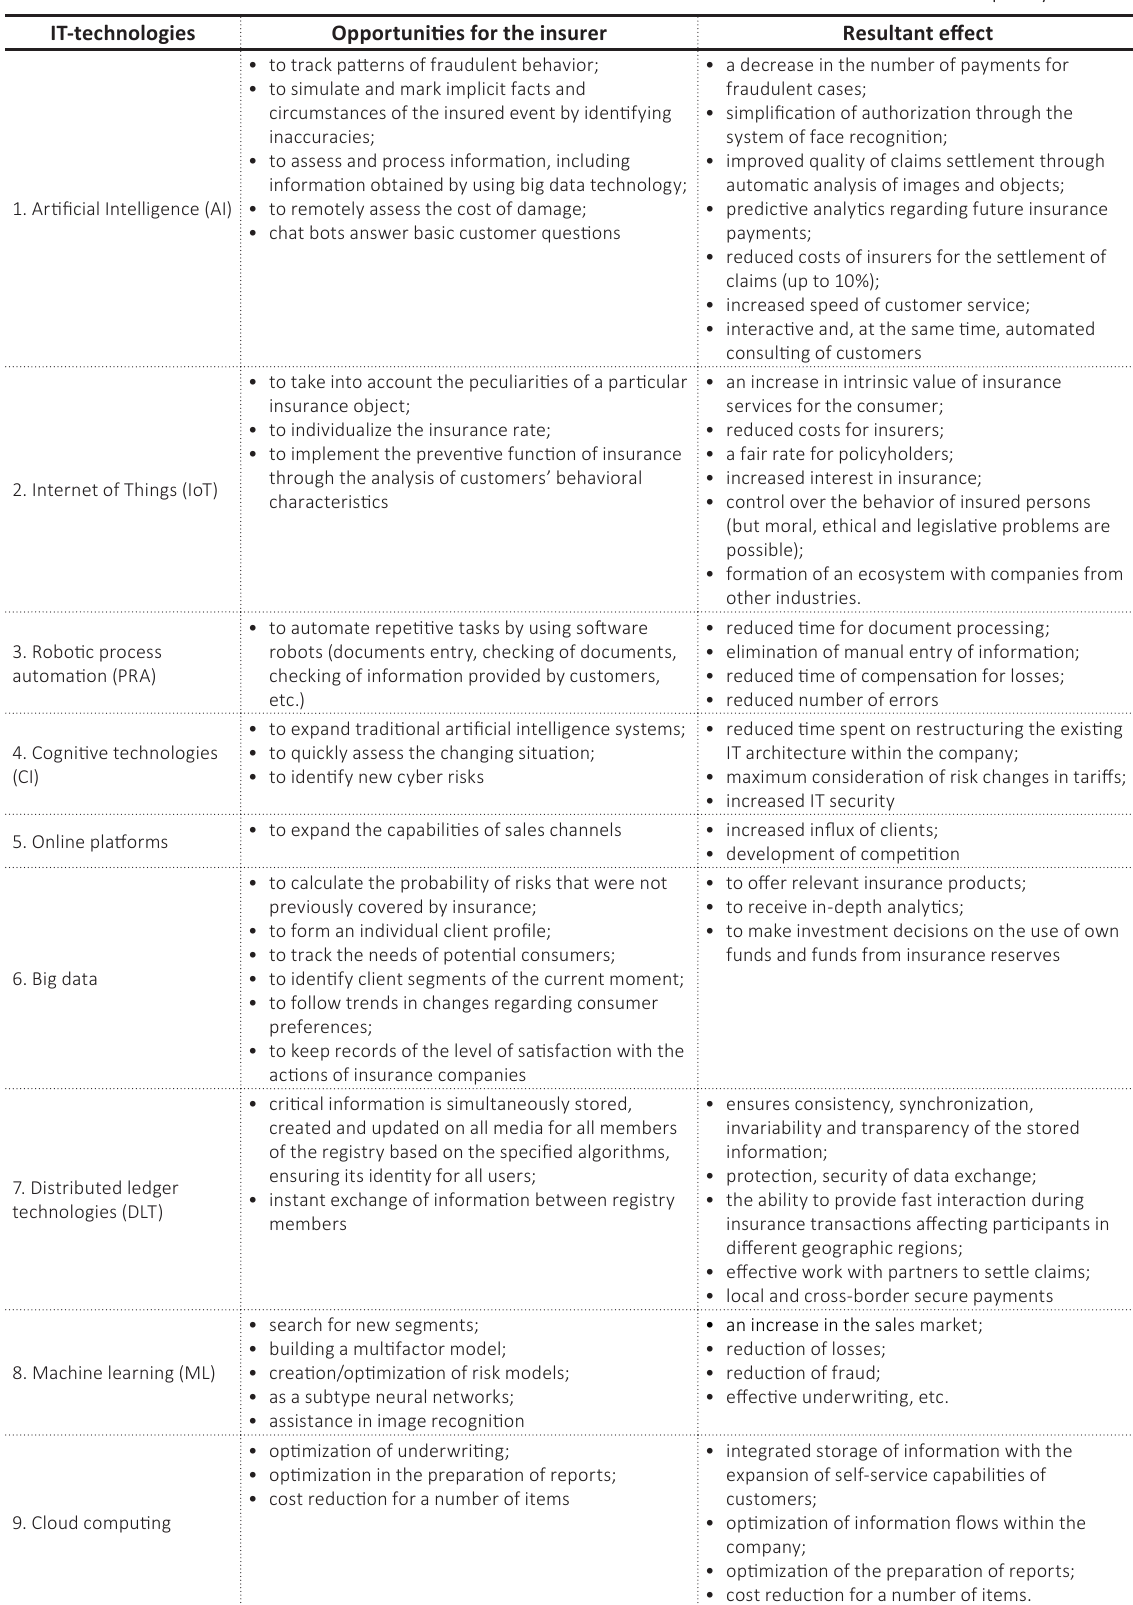
Source: Compiled by the